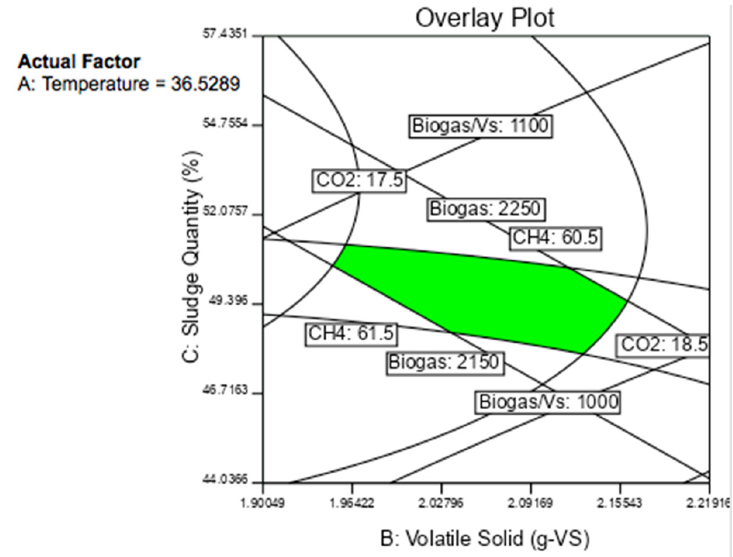
Figure 21. Overlay plot based on the third criterion. Table 13. Energy evaluation of the optimisation criterion.